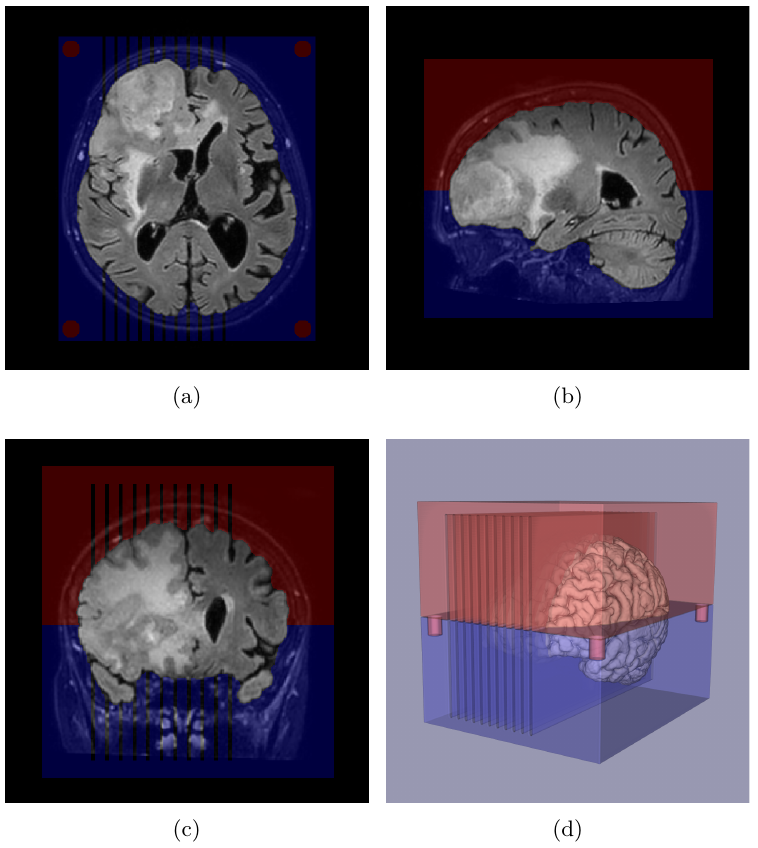
Figure A1. Brain slicer design superimposed to the in vivo T2-FLAIR image used as template in axial ( a ), sagittal ( b ), coronal ( c ) and 3D ( d )